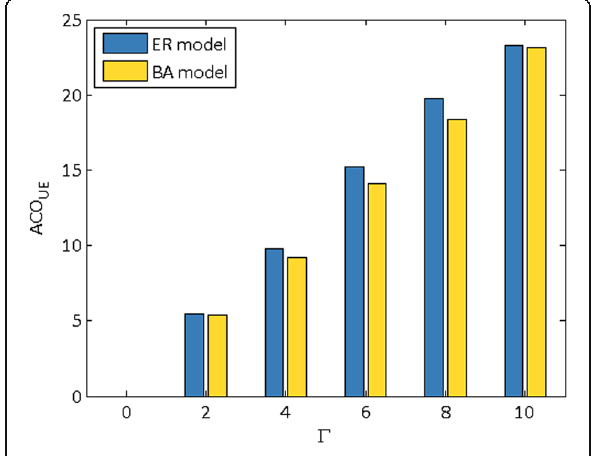
Fig. 25 Impact of Zipf parameter to ACO in the UE level in